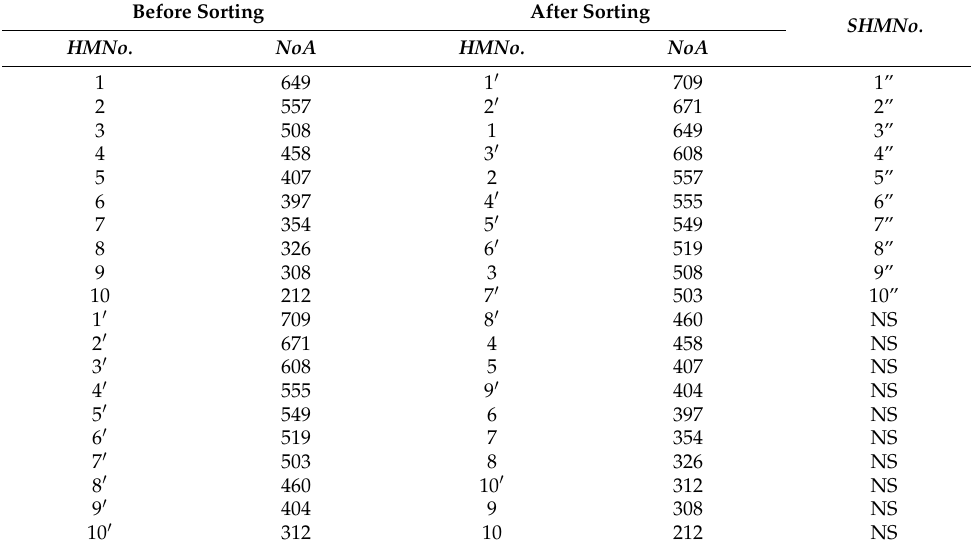
Table 13. Selection of harmonies for next